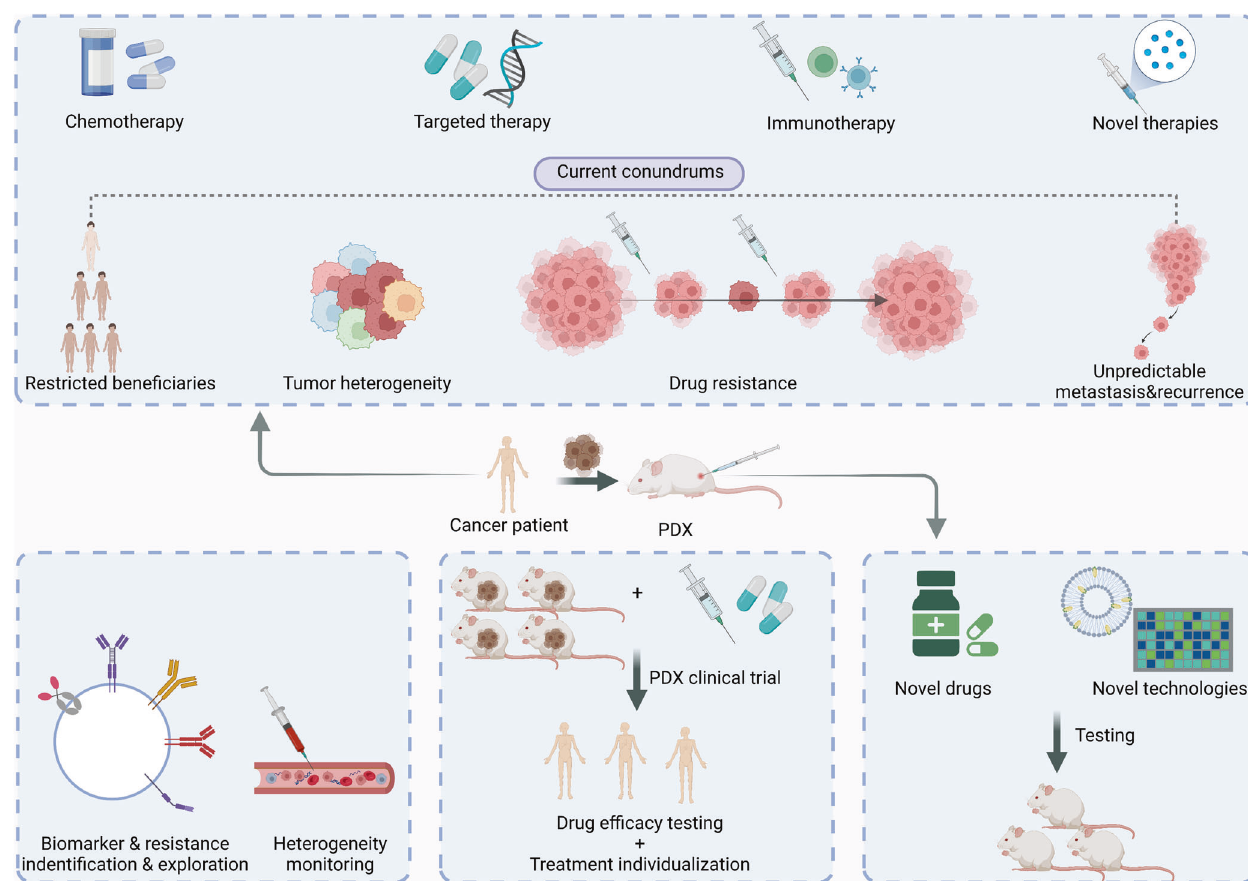
Fig. 1 PDX in the new era of cancer treatment. This fi gure shows the current conundrums of cancer treatment including restricted bene fi ciaries, tumor heterogeneity, drug resistance as well as tumor metastasis and recurrence, and shows the versatile functions of PDX in developing therapeutics against